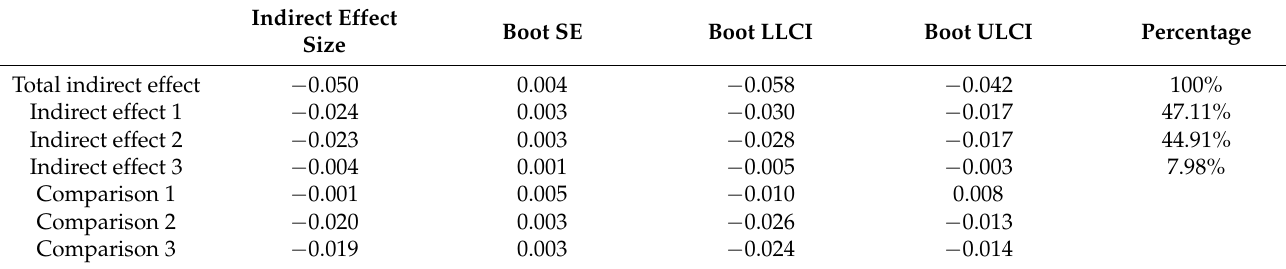
Table 3. Mediating effect size comparison.